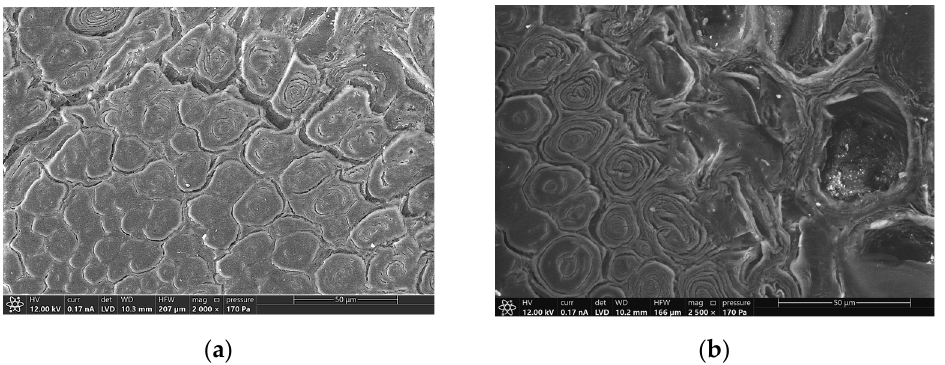
Figure 13. Secondary electrons ESEM images of the border between fibers and ground parenchyma of unaged ( a ) and UV (192 h) aged ( b ) samples, both collected from a vascular bundle of the central part of the culm wall.